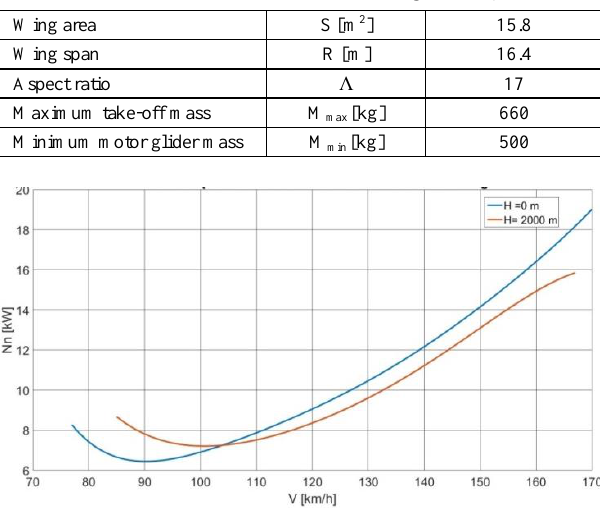
Fig. 3. Power required for flight in the function of flight speed – for the AOS H2 motor glider; M max = 660 kg [13, 14]